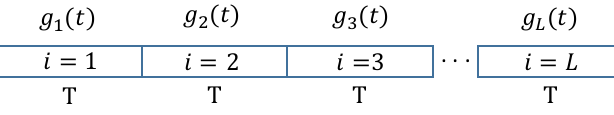
Figure 13. Level curves (in meters) of the transition Range R* for “NV” varying B and T, for m = 1 and m = 5.